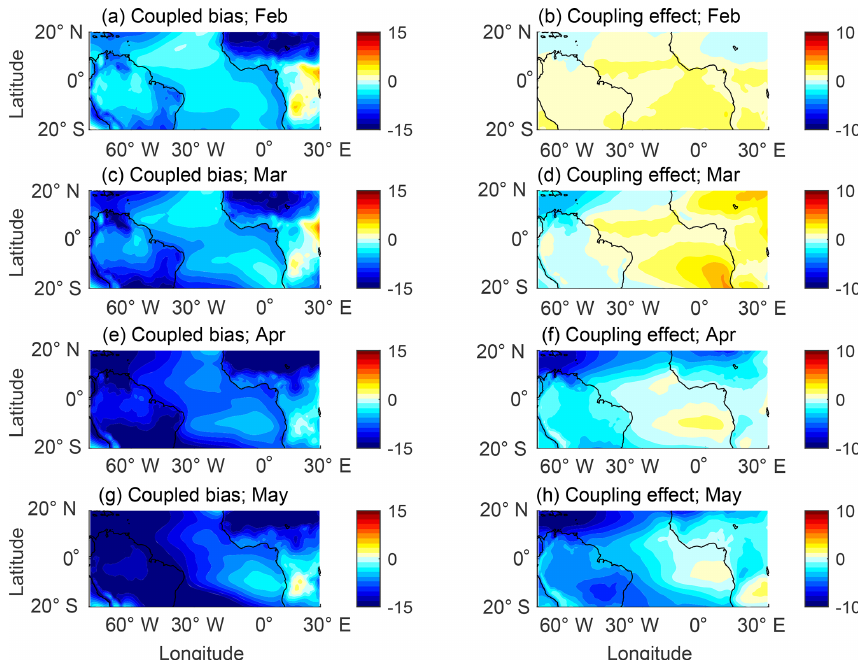
Figure 11. Maps comparing geopotential thickness (in m) between models and observations. Thickness between 700 and 1000hPa is shown. The left column shows the coupled bias in S4 with respect to ERA-Interim; the right column shows the effect of coupling on stability (S4 minus S4A). Averaged over all 14 years of hindcast and over the month in the panel